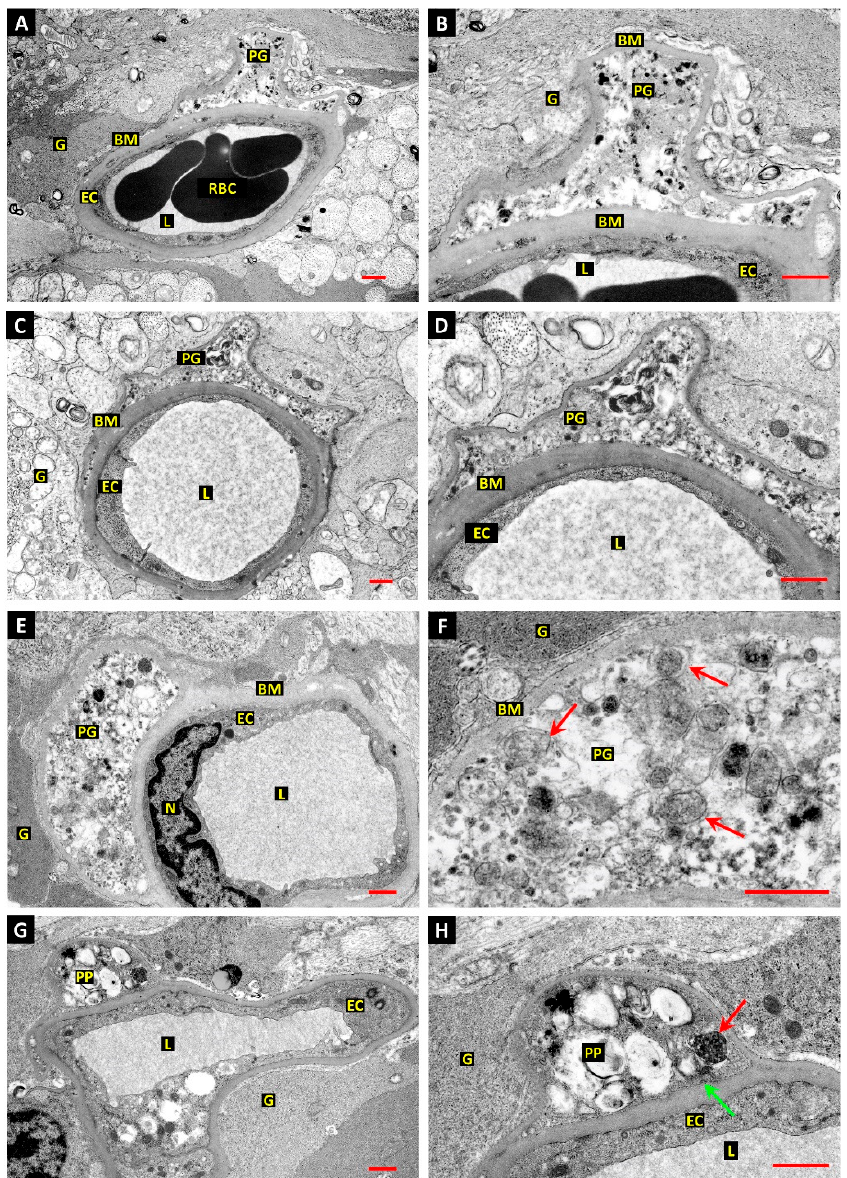
Figure 2. Evidence of autophagy associated with cell death of retinal pericytes in diabetic dogs. ( A – D ): Electron micrographs from retina of 5-year experimental diabetic dog shows a dilated capillary blood vessel with an intact endothelial cell (EC) but no viable pericyte covering. The basement membrane (BM) is grossly thickened and a pericyte “ghost” (PG) filled with vesicular and granular electron- dense material is present within the BM. Red blood cells (RBC), vessel lumen (L), glial processes (G). Bars 1.0 µm. ( E , F ): Retinal capillary as those depicted in panels A–D, shows a pericyte “ghost” filled with granular and vesicular material; endothelial cell nucleus (N). Higher magnification reveals that the vesicles are enclosed by secondary layers of endomembranes, but no intact plasma membrane is discernible. Bar 1.0 µm. ( G , H ): Retinal capillary as those depicted in panels A–D, but with intact pericyte processes. One pericyte process (PP) shows cytoplasmic vacuolation and heterogeneous membrane-bound material suggestive of autophagy. A double-membrane-enclosed dense body (red arrow) may represent a late autophagosome. A clathrin-coated pit (green arrow) is present at the inner aspect of the plasma membrane, indicating continued membrane dynamics. Bar 1.0 µm.